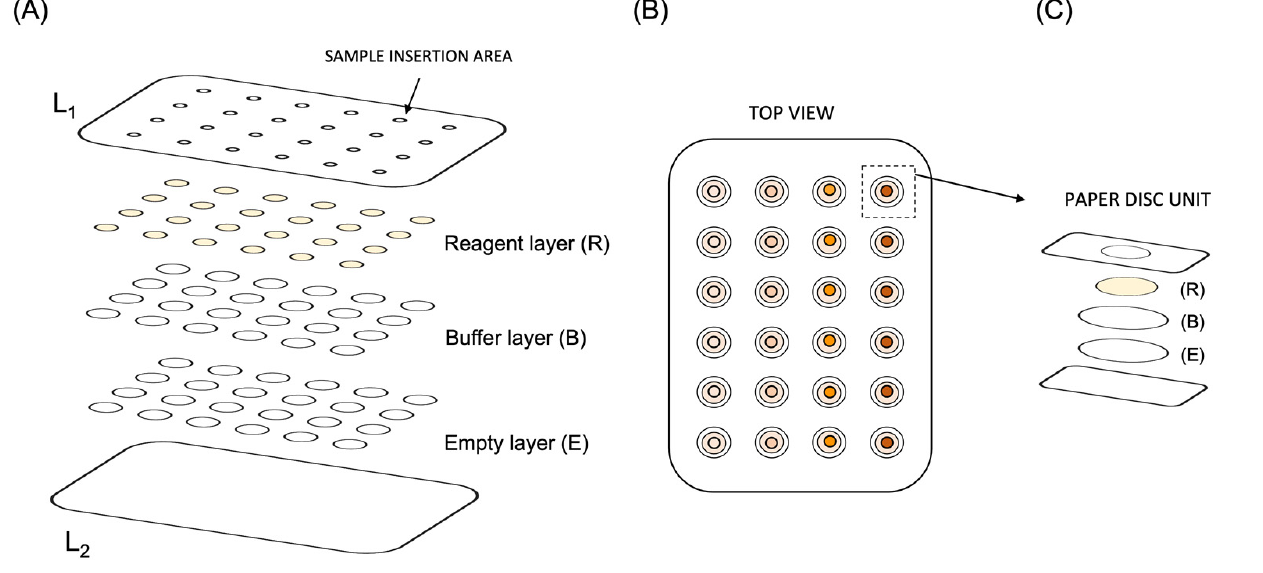
Figure 2. Schematic representation of the µ PAD assembly for iron determination. ( A ) Paper discs alignment, ( B ) the µ PAD detection zone after the sample insertion, and ( C ) illustration of a paper unit of detection; L 1 and L 2 , laminating pouches sheets; R, reagent layer; B, buffer layer; E, empty layer.